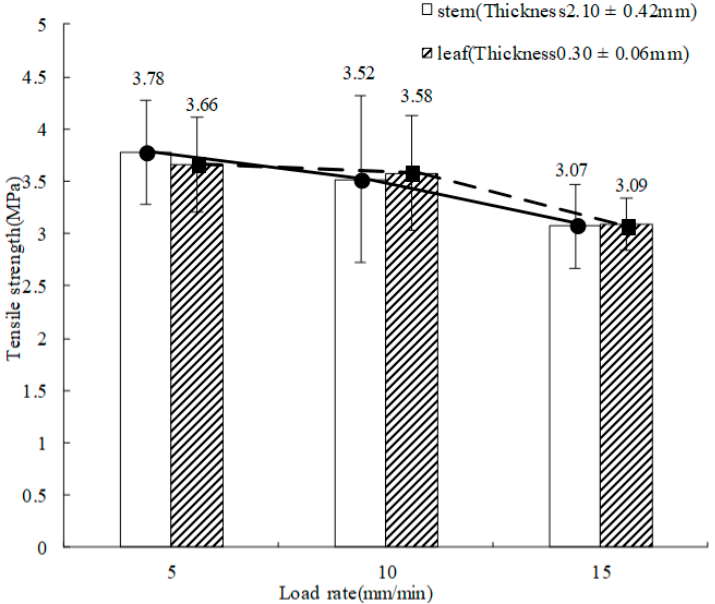
Figure 14. Tensile strength of wakame stem and leaf under different loading rates.